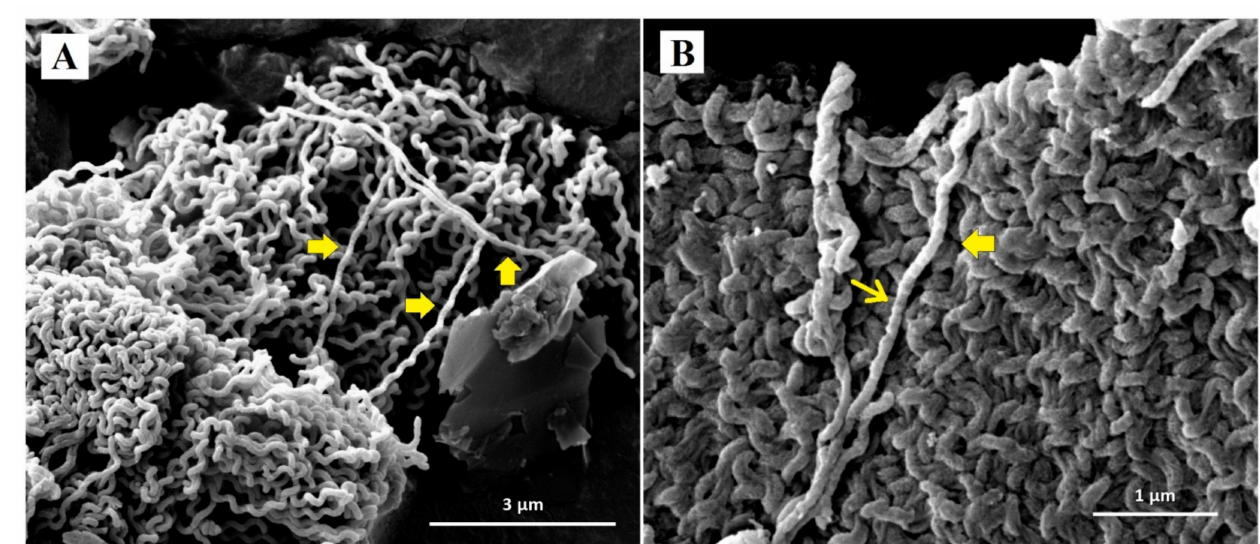
Figure 4. SEM micrographs of L. interrogans serovar Australis treated with MIC AE at 30,000 × ( A ) and 60,000 × ( B ) magnifica- tions. Block arrows: less coiling; arrow: irregular surfaces of Leptospira cells.